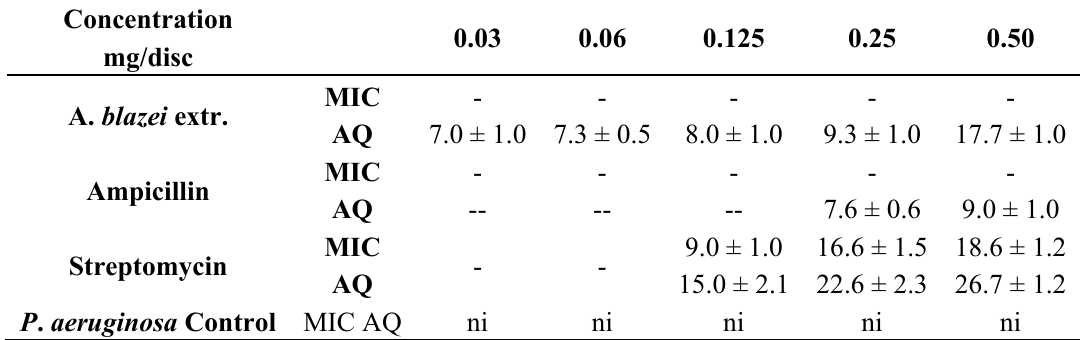
Table 2. Minimal inhibitory (MIC) and antiquorum (AQ) zones in mm induced by Agaricus blazei extract in the disc-diffusion method (mean ±